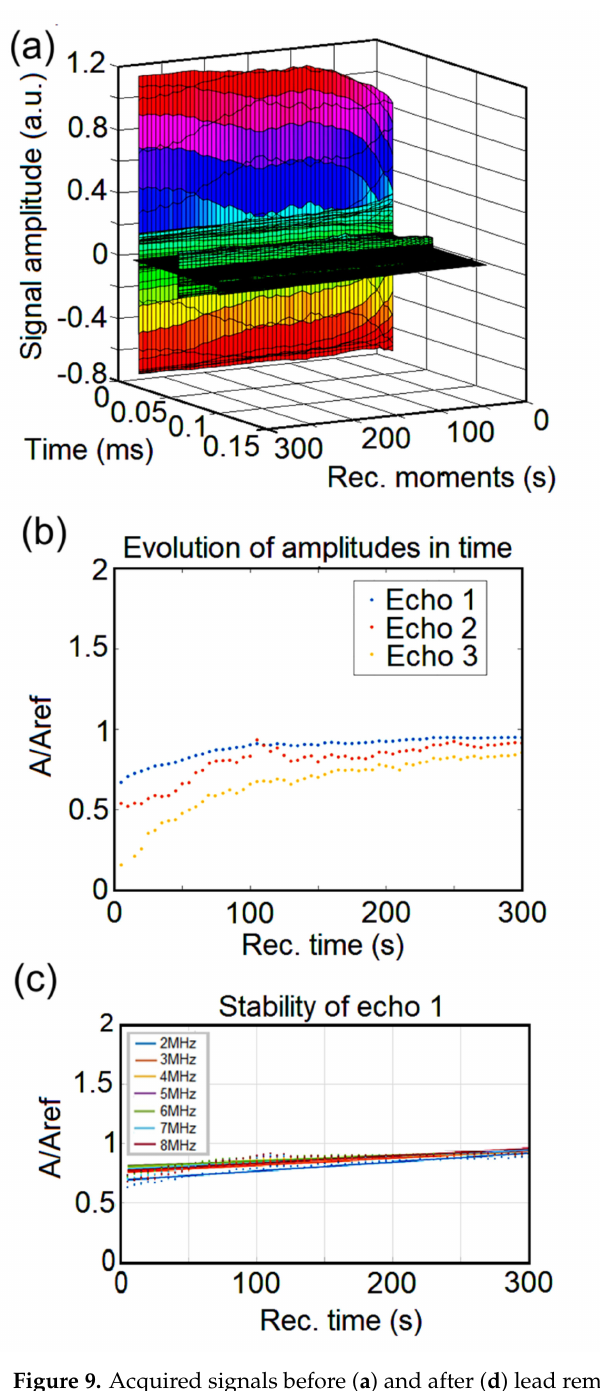
Figure 9. Acquired signals before ( a ) and after ( d ) lead removal. Evolution of amplitude in time before ( b ) and after lead removal ( e ); stability of echo 1 before ( c ) and after ( f ) lead